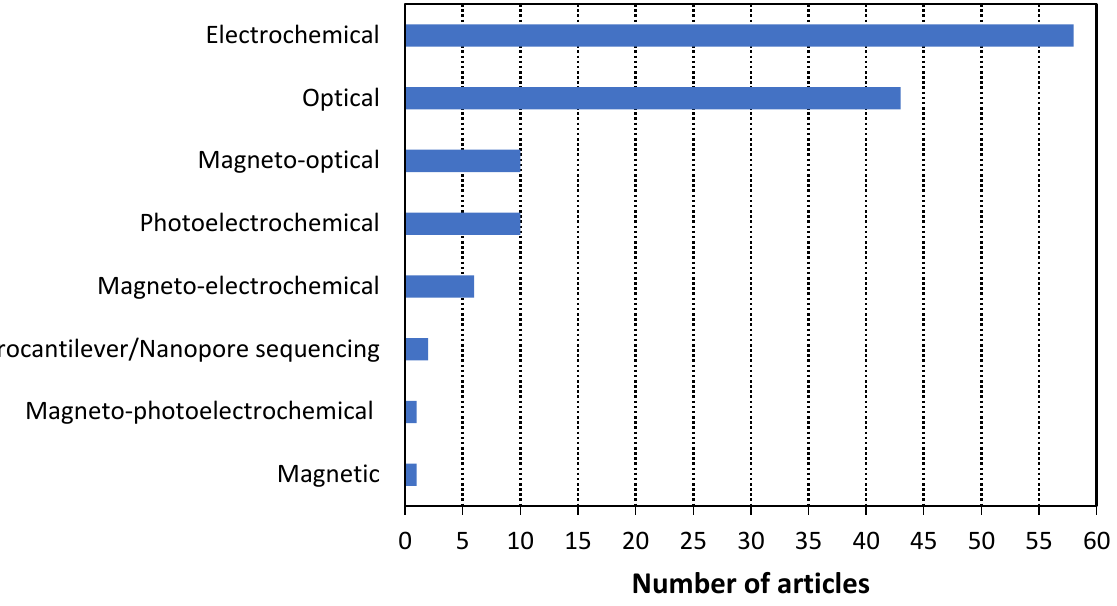
Figure 11. Histogram of the articles of the three biorecognition technologies by detection method.